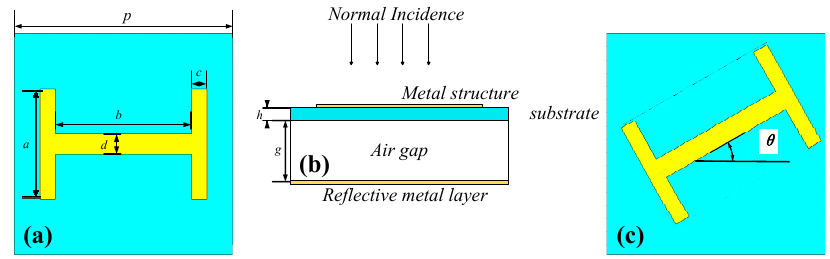
Figure 1. The model of the proposed PB unit cell: ( a ) Front view. ( b ) Side view. ( c ) Rotated view. For the PB metasurface, the phase of the reflected wave can be controlled by the dif- ferent rotation angles θ (anticlockwise) of the I shaped structure. For an incident CP wave, the polarization of the reflected wave is preserved, and |2 θ | abrupt phase change com- a right-handed CP (RHCP) wave and − 2 θ for a left-handed CP (LHCP) wave [31]. That